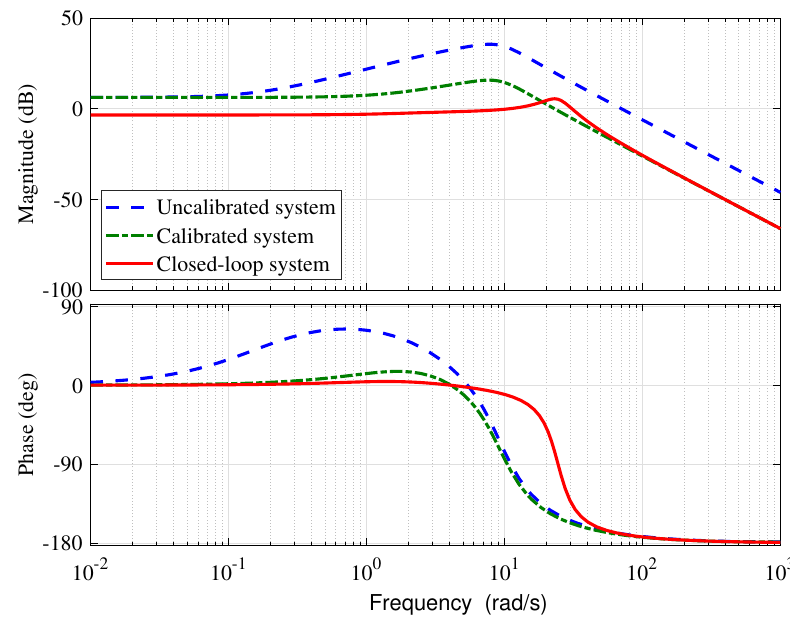
Figure 9. Bode diagram of elevation